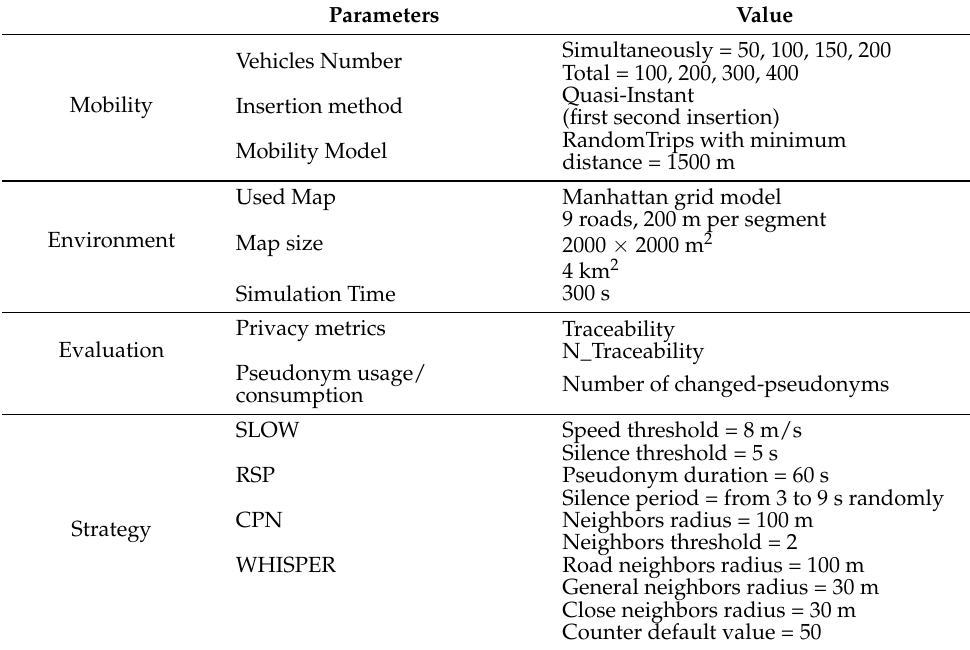
Figure 10. The block diagram of the different used simulation tools. Table 3. Simulation parameters and